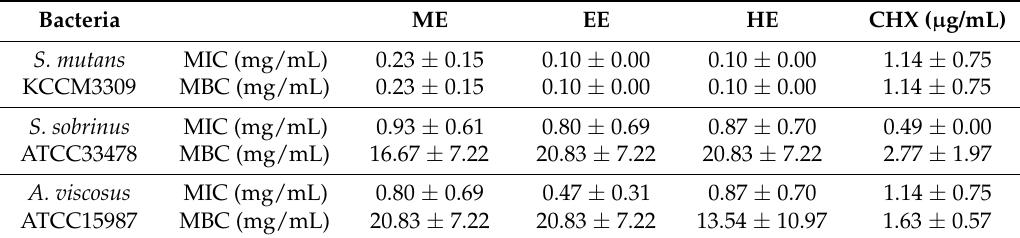
Table 3. Minimum inhibitory concentration (MIC) and minimum bactericidal concentration (MBC) of P. cubeba L. extracts.